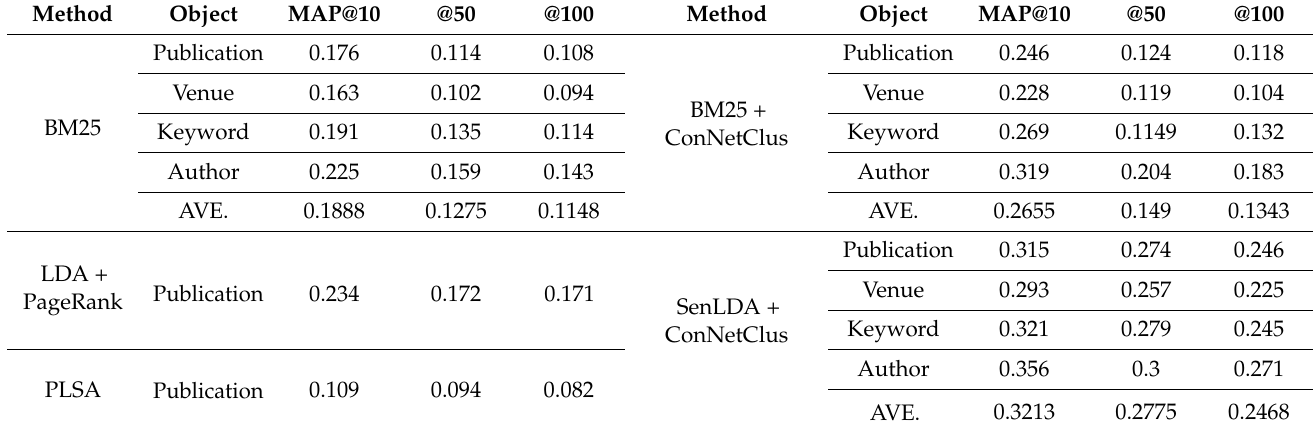
Table 3. Experimental results of MAP.